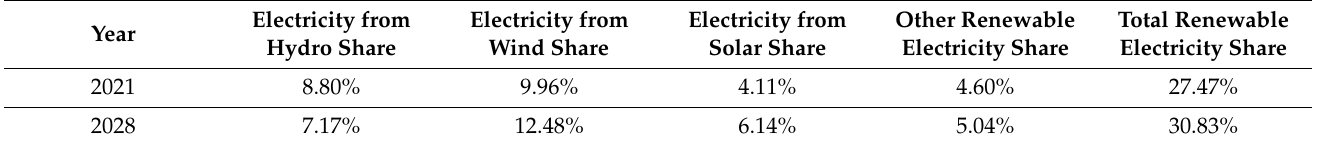
Table 4. Growing estimate for renewable energies. Source: own